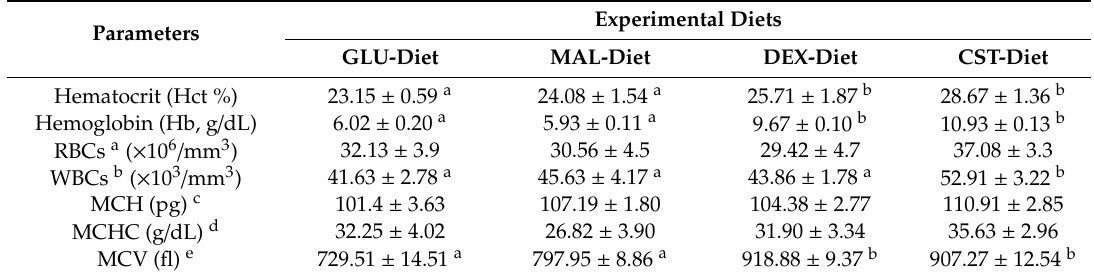
a RBCs: red blood cells count. b WBCs: white blood cells count. c MCH: mean cellular hemoglobin = (Hb / RBCs). d MCHC: mean cellular hemoglobin concentration = (100 Hb / Hct). e MCV: mean corpuscular volume = (Hct / RBCs), expressed in femtolitre (fl).